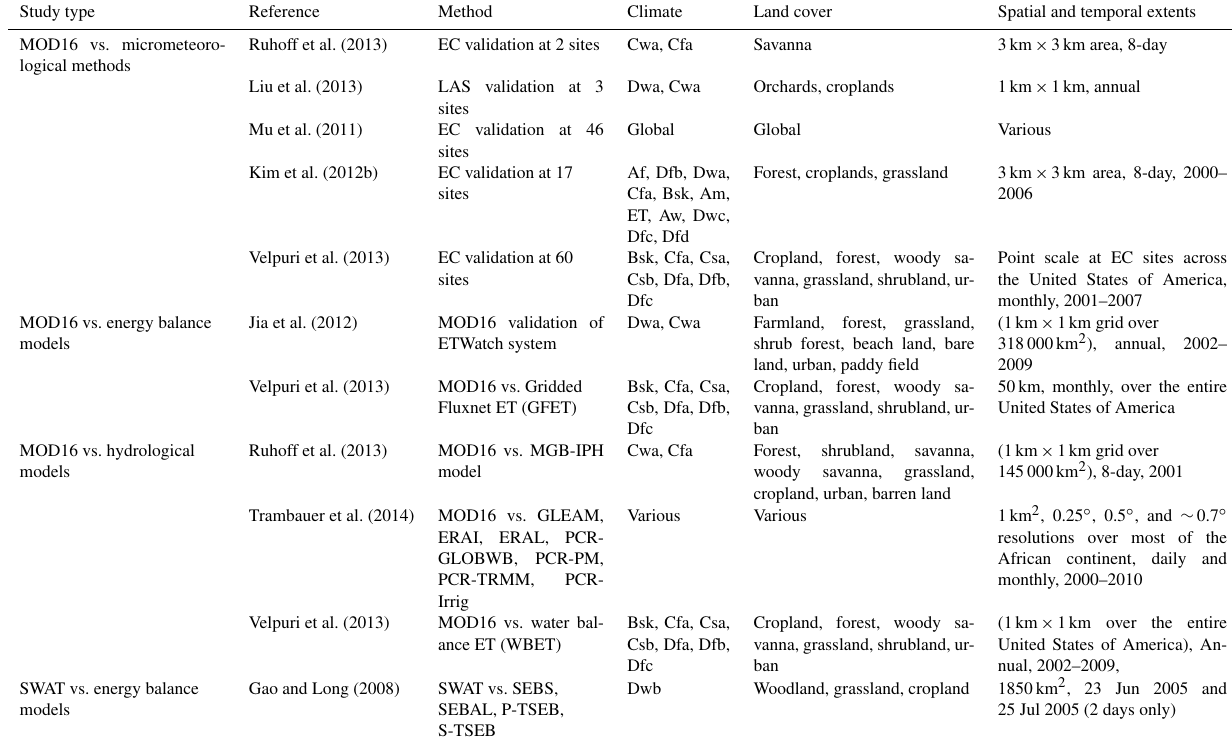
Table 1. Literature studies of MODIS and SWAT evapotranspiration (see Table 2 for climate classification). Study type